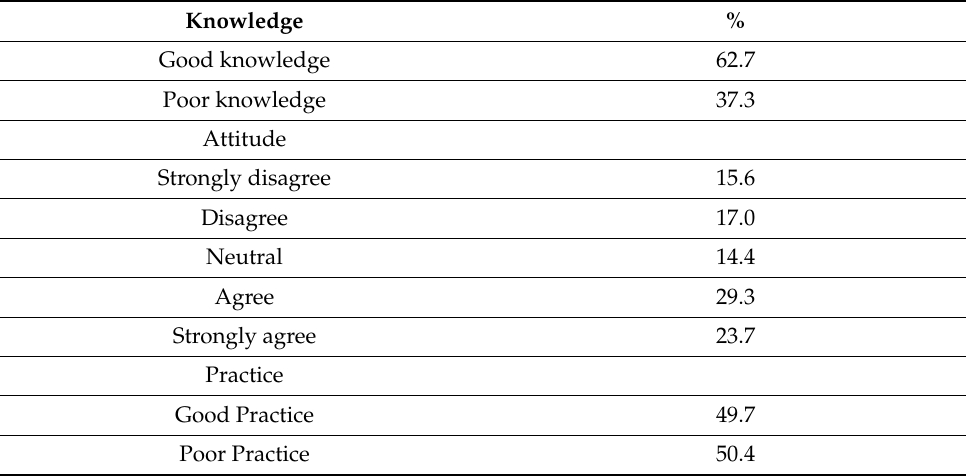
Table 2. Percentage of respondents with knowledge, attitude and practice score.